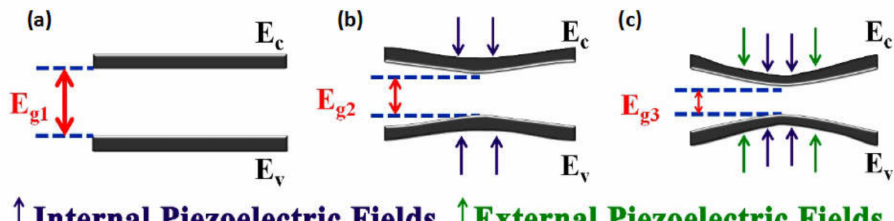
Figure 8. Band gap structure of PVDF/ZnS:Mn ( a ) under no stress; ( b ) under internal piezoelectric fields; and ( c ) under internal and external piezoelectric